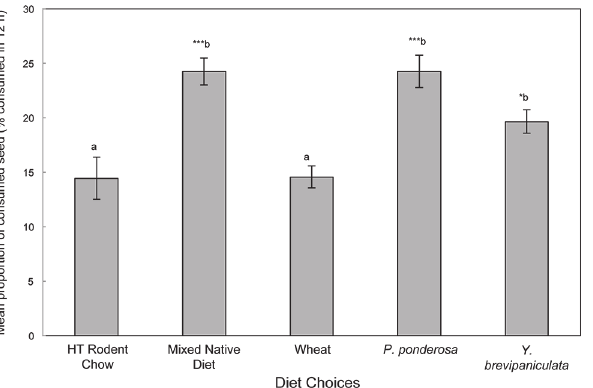
Fig 2. Seed choice based on proportion of the feed consumed in multiple-choice feeding trials. Deer mice consumed approximately 20% of their diet as bamboo ( Yushania brevipaniculata ) seeds (per 12 h); they consumed significantly more bamboo (P < 0.05 * ) mixed native seeds (P < 0.001 *** )(1:1 mix of Balsamorhiza sagittata and Pseudoregnaria spicata ) and Pinus ponderosa seeds (P < 0.001 *** ) than locally grown wheat seeds or Harlan-Teklad Rodent Chow (ANOVA, F 3,8 = 3.45 , P <